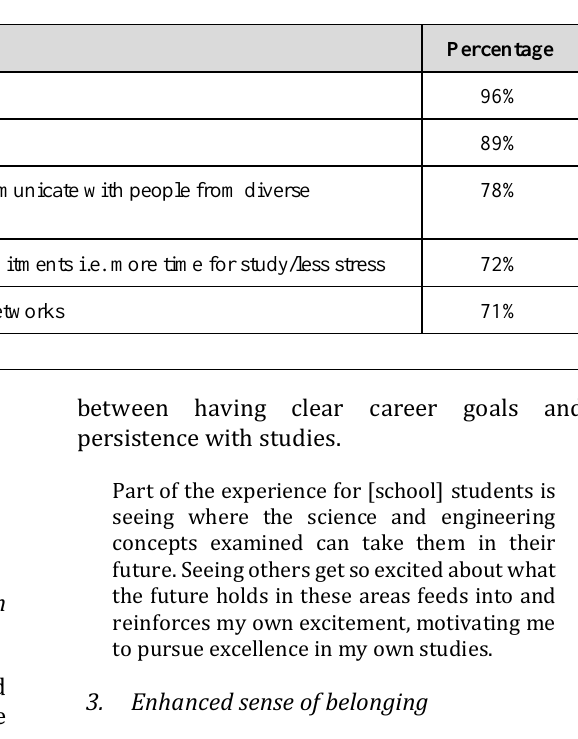
How the ambassador role has helped with university studies (expressed as a percentage of strongly agree/agree